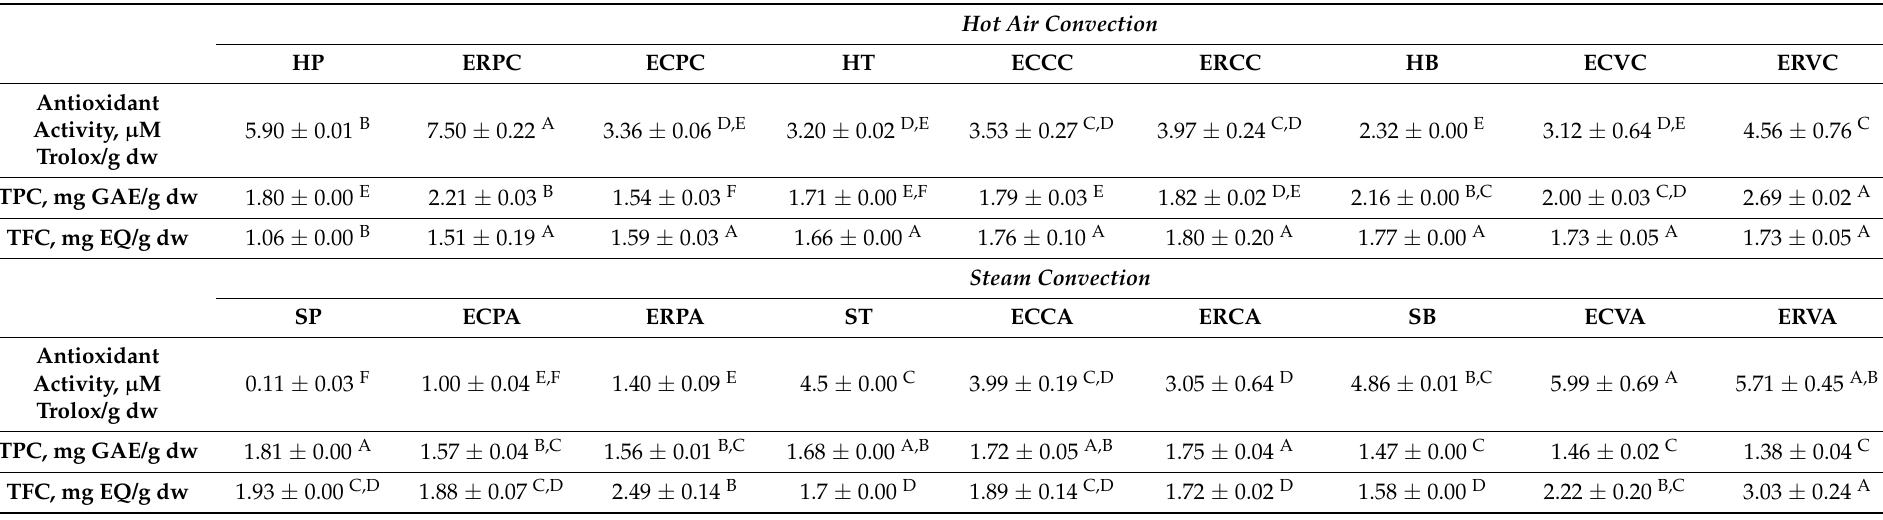
Table 1. Phytochemical profile of herbal aqueous extract enriched